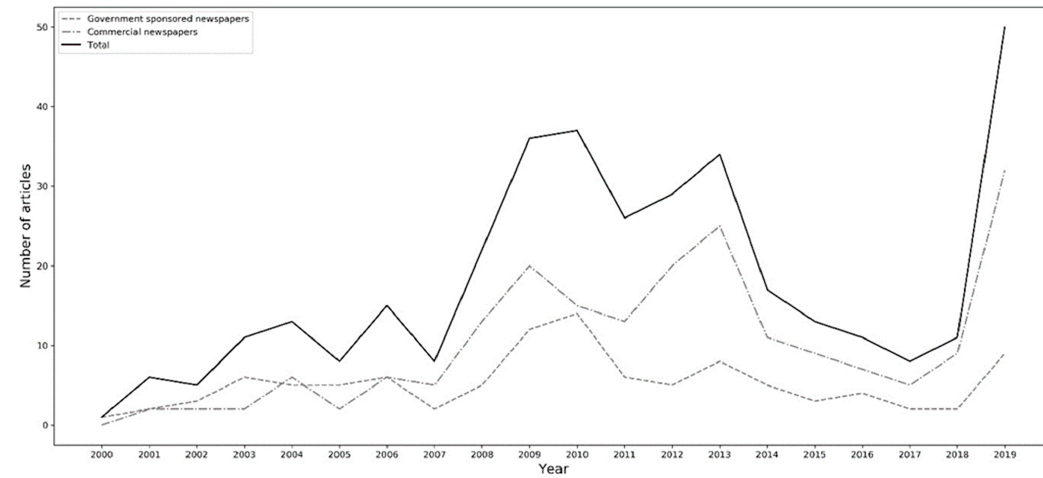
Figure 2. Plot of articles across time.